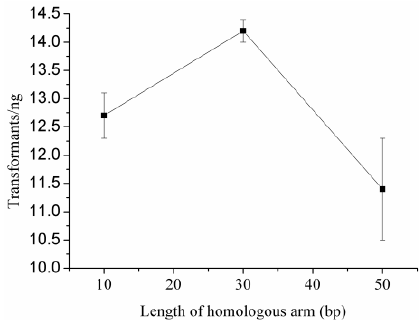
Figure 5. Optimal length analysis of homology arms. The DNAs having 30-bp homology arms created higher transformant efficiency and plasmid accuracy than those having 10- and 50-bp homology arms.